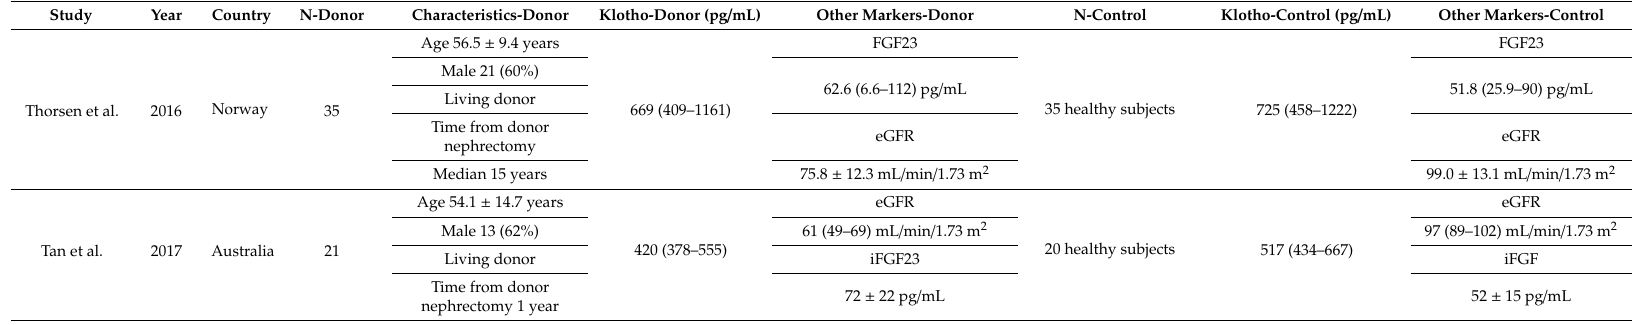
Table 4. Characteristics of the included studies comparing serum klotho between living kidney donors and healthy